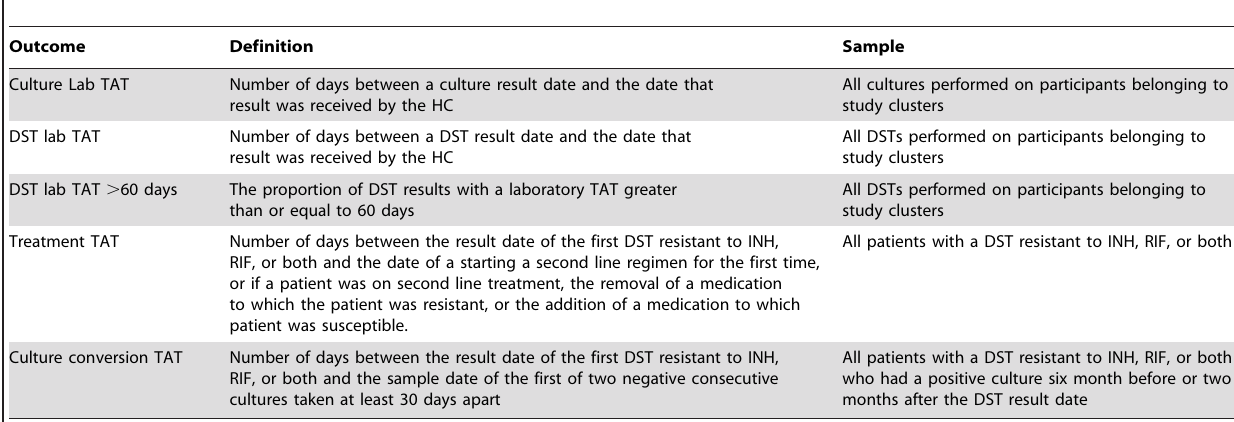
Table 1. Outcome definitions for turn-around-times (TAT) and their respective sample.